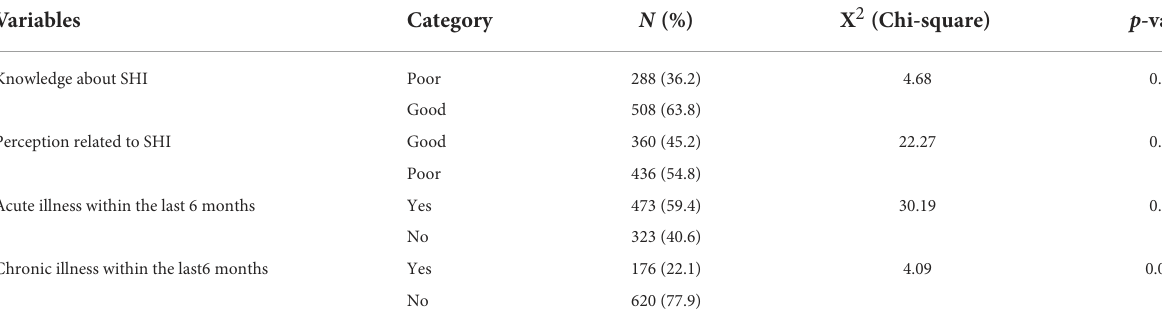
TABLE 4 Knowledge and Illness related factors of public civil servants in DCA, North-East Ethiopia ( n = 796), May 2021.